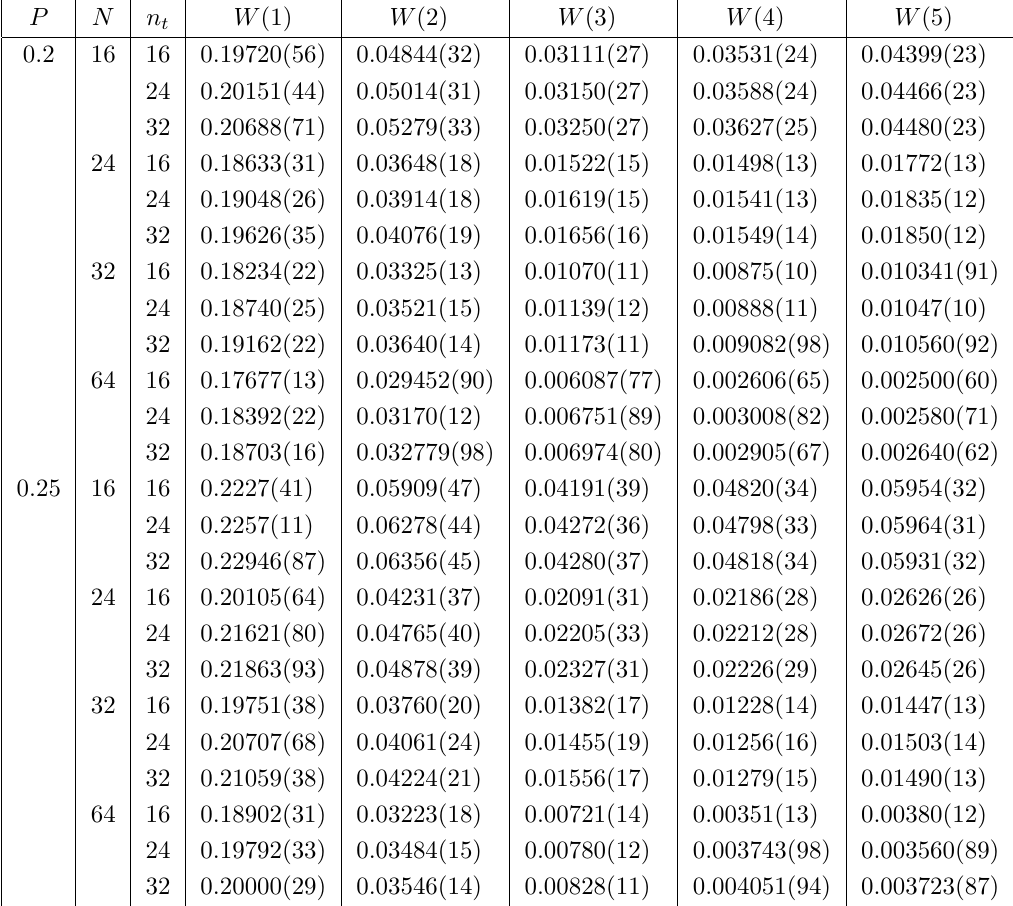
Table 10. W con for L = 1 , 2 , 3 , 4 , 5 , constrained, T = 0 . 29